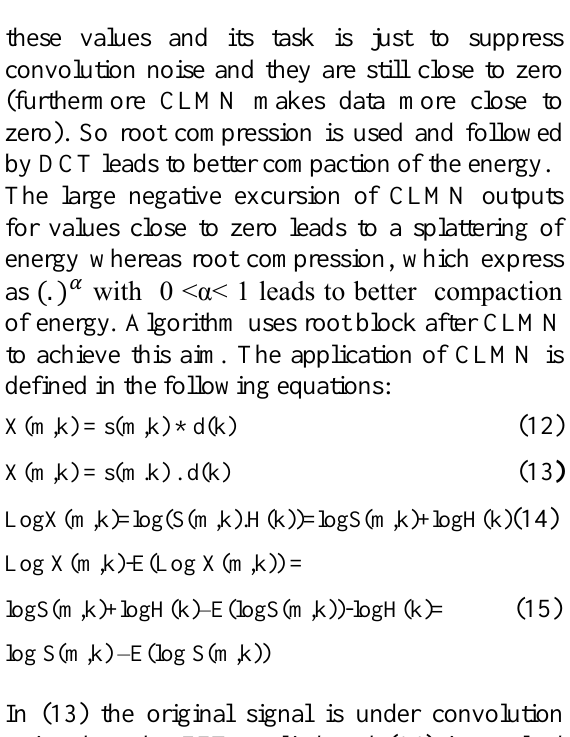
Figure 4. a: Triangular filter bank , b: Gaussian